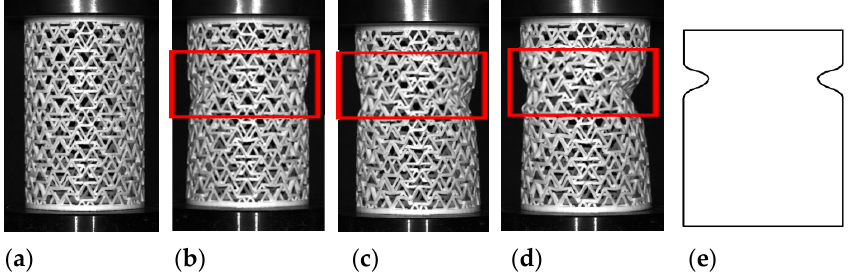
Figure 14. The deformation modes of composite [60°/ − 60°] RHCS: ( a ) the initial configuration; ( b ) the deformation modes in the elastic stage; ( c , d ) the deformation modes in the plateau stage; ( e ) the S deformation